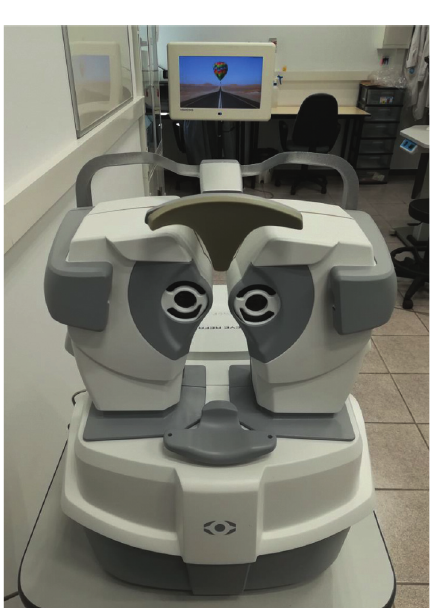
Figure 1: Image of the Eye Refract system and the digital screen